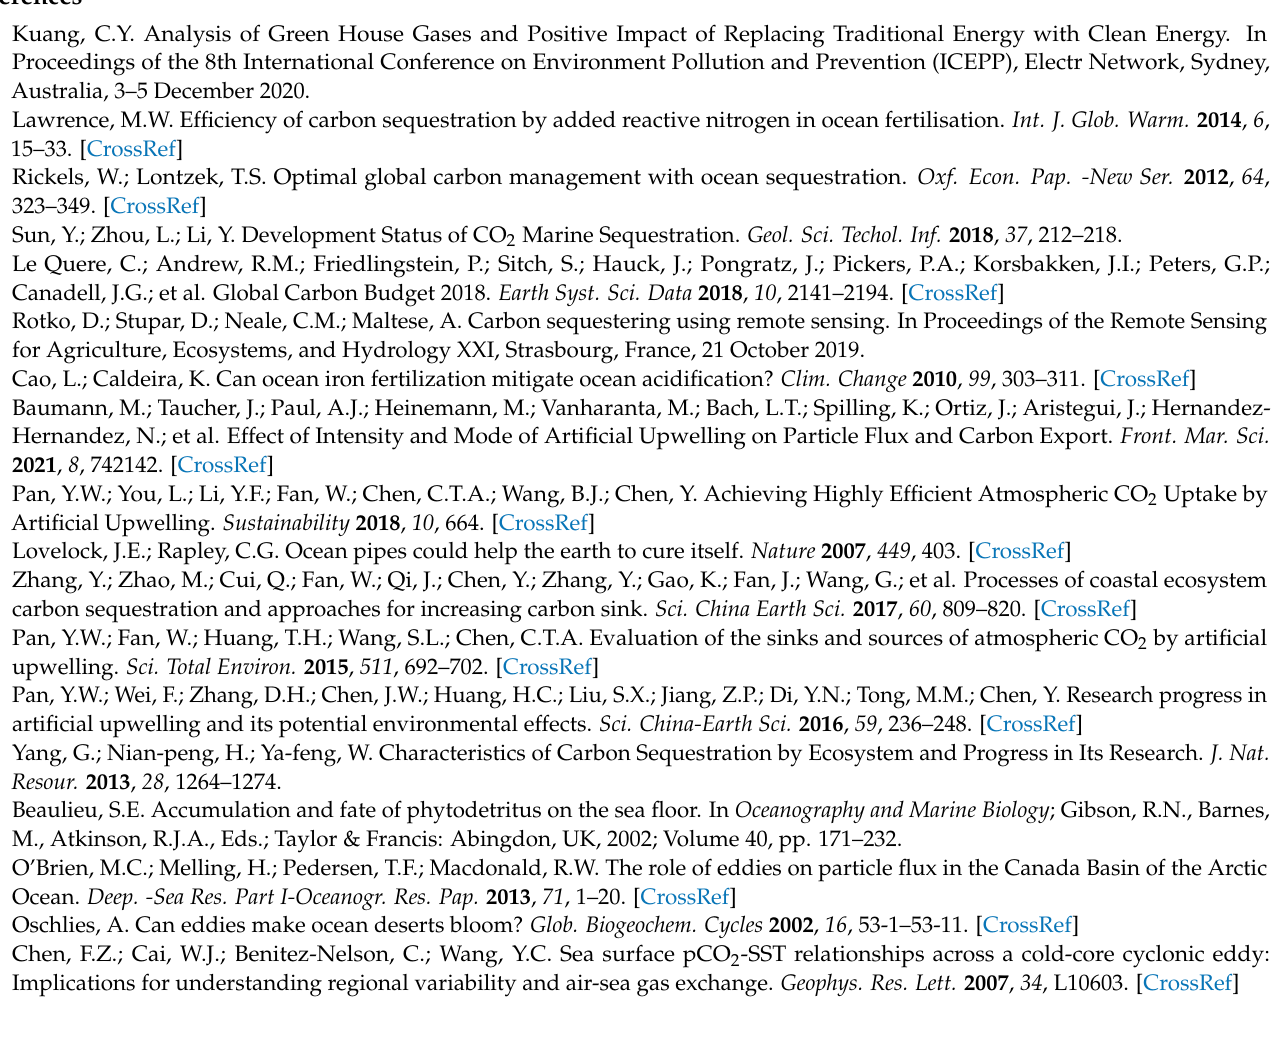
Table S2: Potential environmental factors for the bacterial phyla composition revealed by